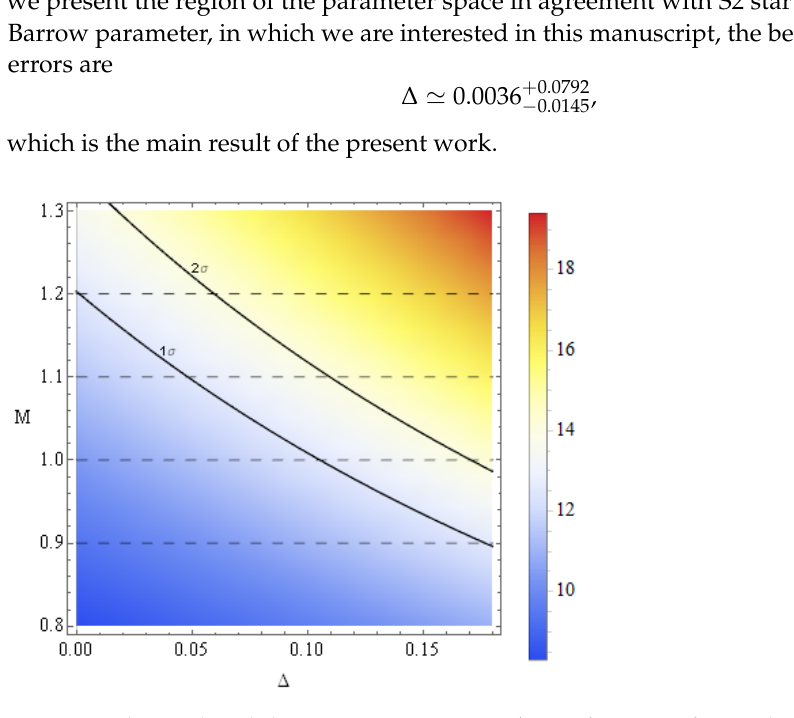
Figure 4. The predicted diameter per unit mass d , as a function of M and ∆ . The black curves correspond to the observationally determined upper 1 σ and 2 σ bounds given in (36) (the lower ones are not shown since they correspond to the not physically interested region ∆ < 0).